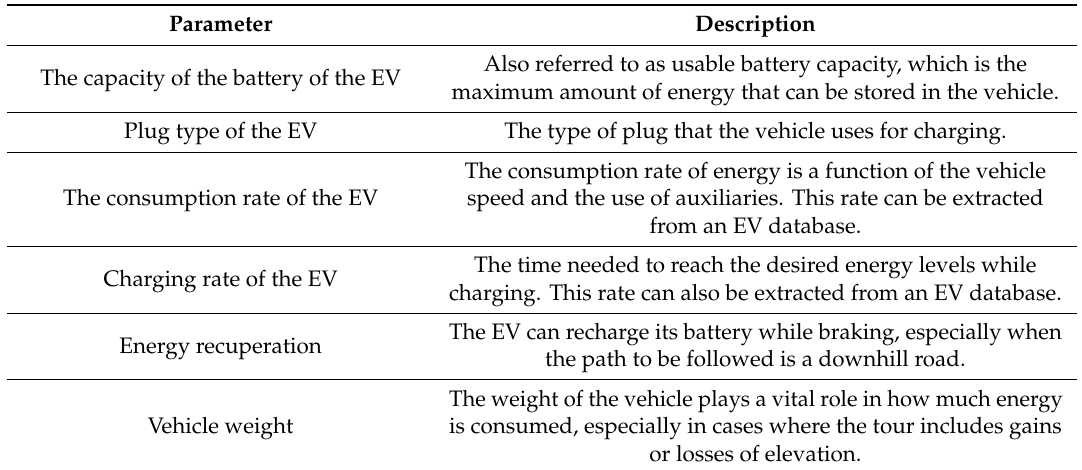
Table 2. The second group of parameters concerning the characteristics of the Electric Vehicle (EV).